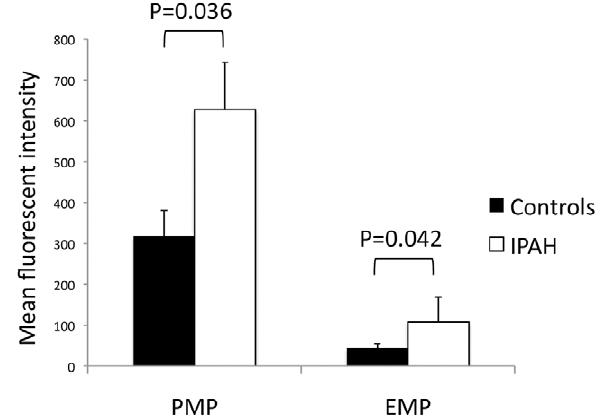
Figure 3. CD39 expression on platelet and endothelial microparticles. Flow cytometry revealed significantly increased surface CD39 expression on platelet (CD31 + CD42b + ) and endothelial (CD31 + CD42b 2 ) microparticles. PMP = platelet microparticles, EMP = endothelial microparticles.